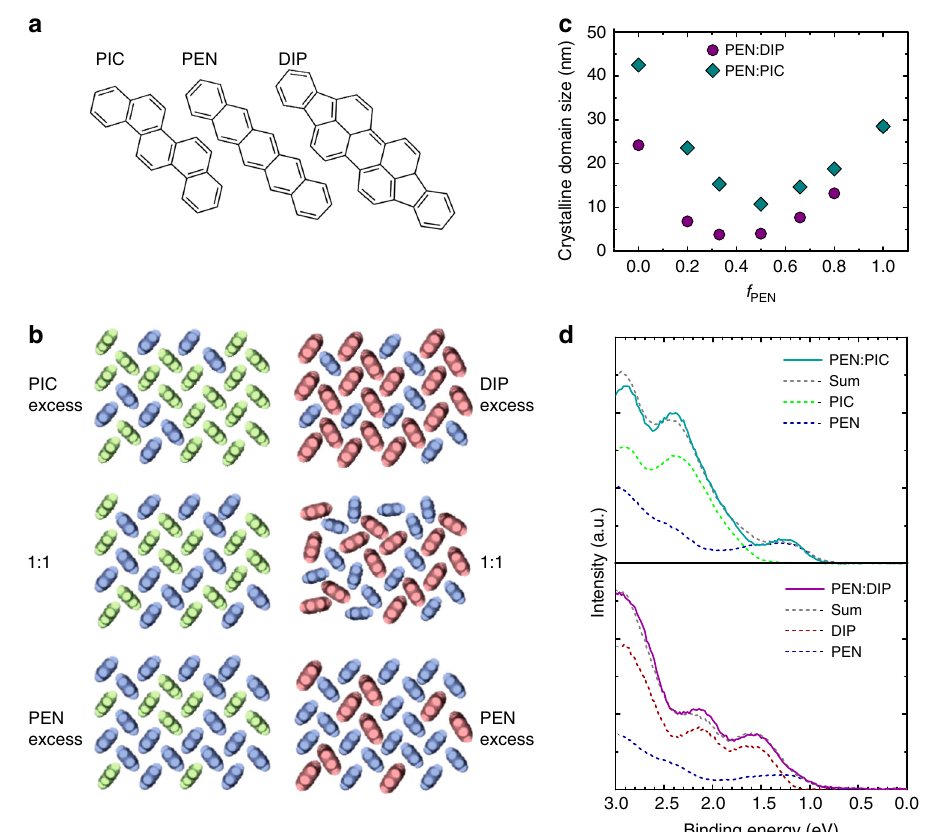
Fig. 1 Structural and photoelectric characterization of the systems. a Chemical structure of PEN and the spacer molecules PIC and DIP. b Schematic mixing behavior (top view, parallel to the substrate surface) of PEN:PIC (left column) and PEN:DIP (right column). c Crystalline domain size extracted from grazing incidence X-ray diffraction 21,22 . d Ultraviolet photoelectron spectroscopy data of the HOMO region of PEN, DIP, PIC, and the respective equimolar blends. Binding energies are given relative to the Fermi level. The gray dotted lines are the sum of the HOMO regions of the pure compounds, weighed according to the mixing